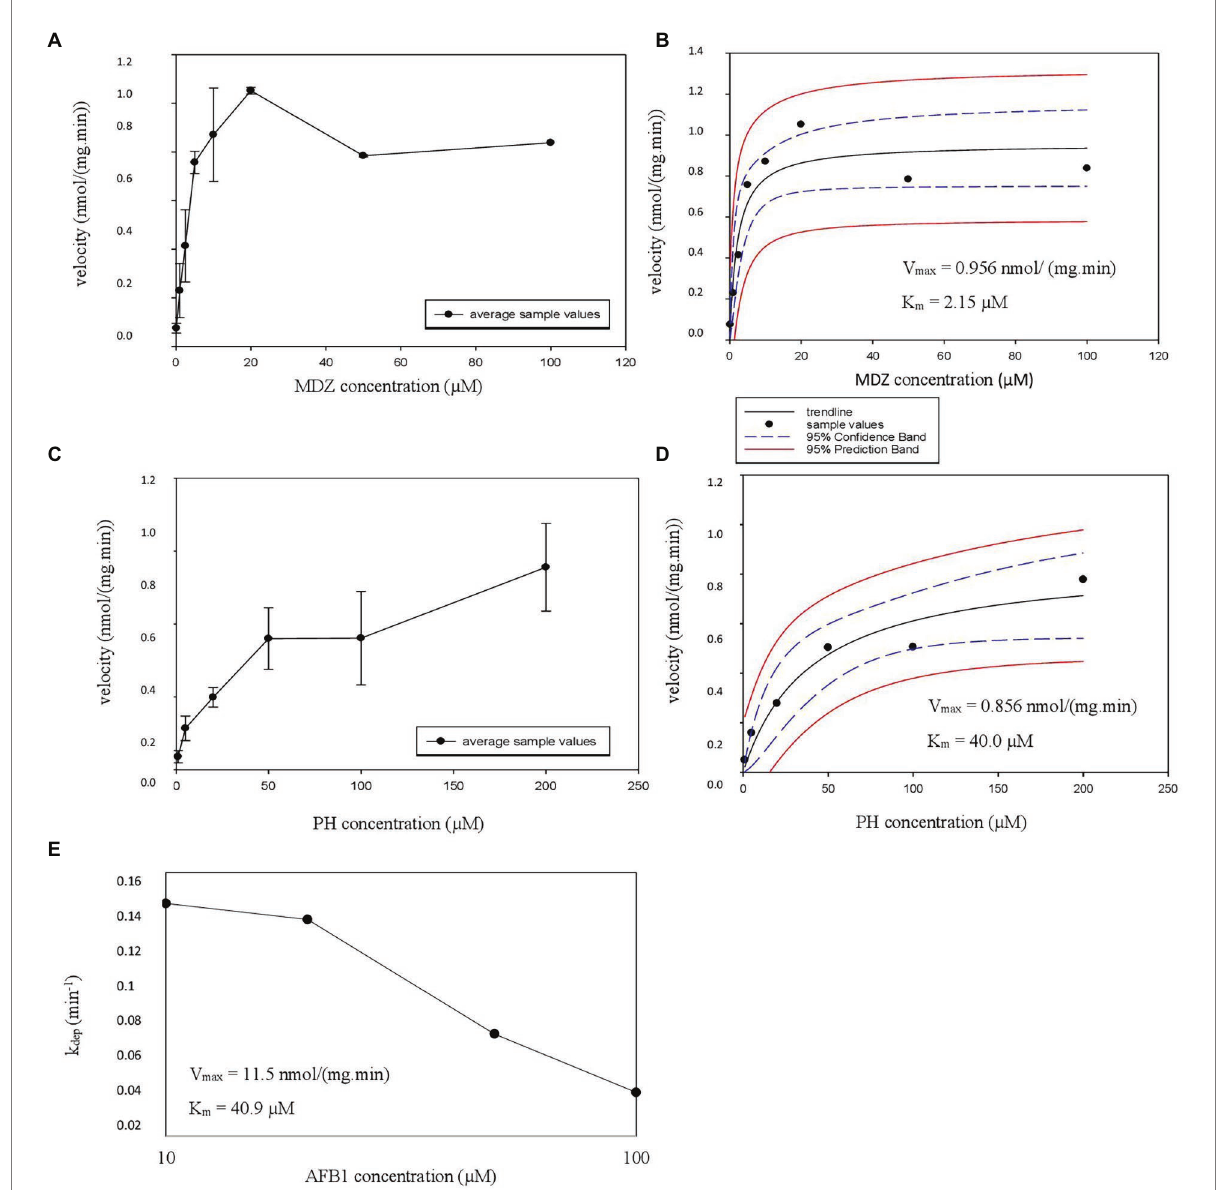
FIGURE 2 (A–E) Michaelis Menten constant ( K m ), estimated maximum velocity ( V max ) HLM experiment graphs. (A,C) The velocity as a function of the added CYP probe concentration is illustrated with error bars. The formation of hydroxy-midazolam (OH-MDZ) and acetaminophen (AC) is given from top to bottom. (B,D) The nonlinear regression Michaelis–Menten curves are given with the estimated V max and K m values, also from top to bottom in the same order, 95% confidence band and 95% prediction band are presented as well. (E) Represents the parent depletion of AFB1 where k dep is represented on the y-axis and aflatoxin B1 (AFB1) concentration on the x-axis with the estimated V max and K m